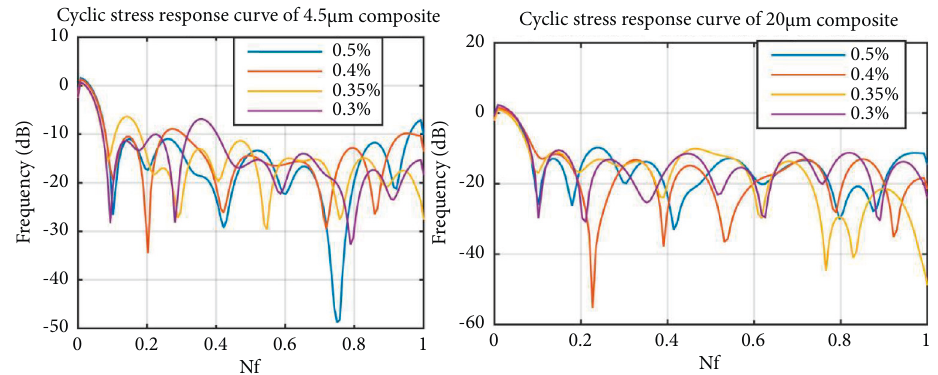
Figure 6: Cyclic stress response curve of composite